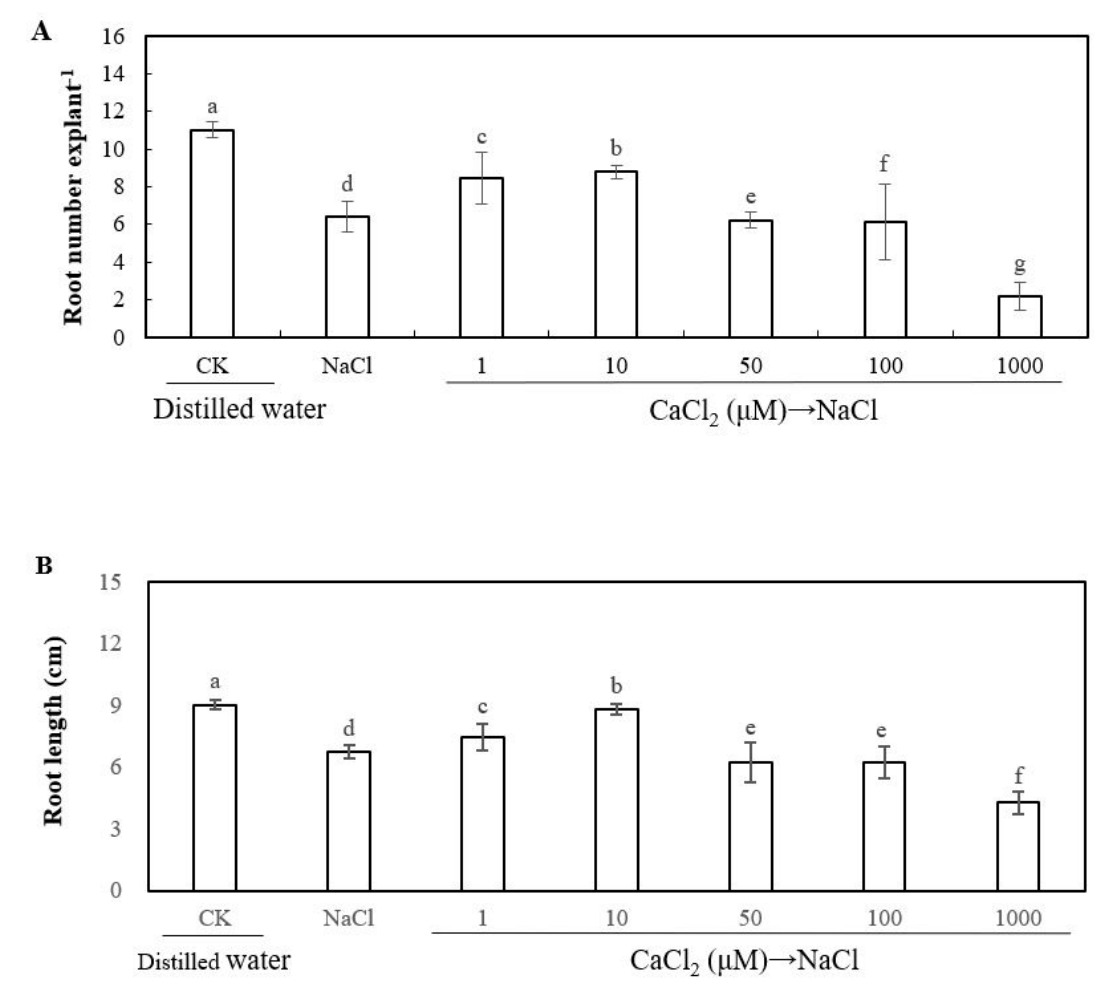
Figure 2. Effects of different concentrations of calcium chloride (CaCl 2 ) on adventitious root development in cucumber explants under salt stress. The primary roots were removed from hypocotyl of five-day-old seedlings. The explants were incubated for five days with distilled water as control. Explants were incubated with 13 mM NaCl in three days after being treated with distilled water or different concentrations of CaCl 2 treatments, respectively, for two days. The numbers ( A ) and root length ( B ) of adventitious root were expressed as mean ± SE ( n = 3, 10 explants were used per replicate). Bars with different lowercase letters were significantly different by Duncan’s multiple range test ( P < 0.05).